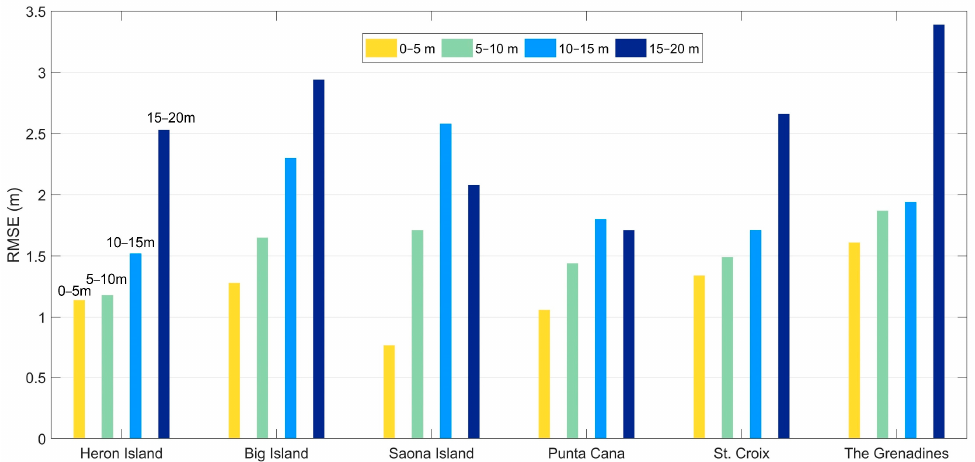
Figure 9. Root mean square error (RMSE) comparisons across different depth ranges. Deep depth regions (>15 m) have higher RMSE than shallow depth regions.